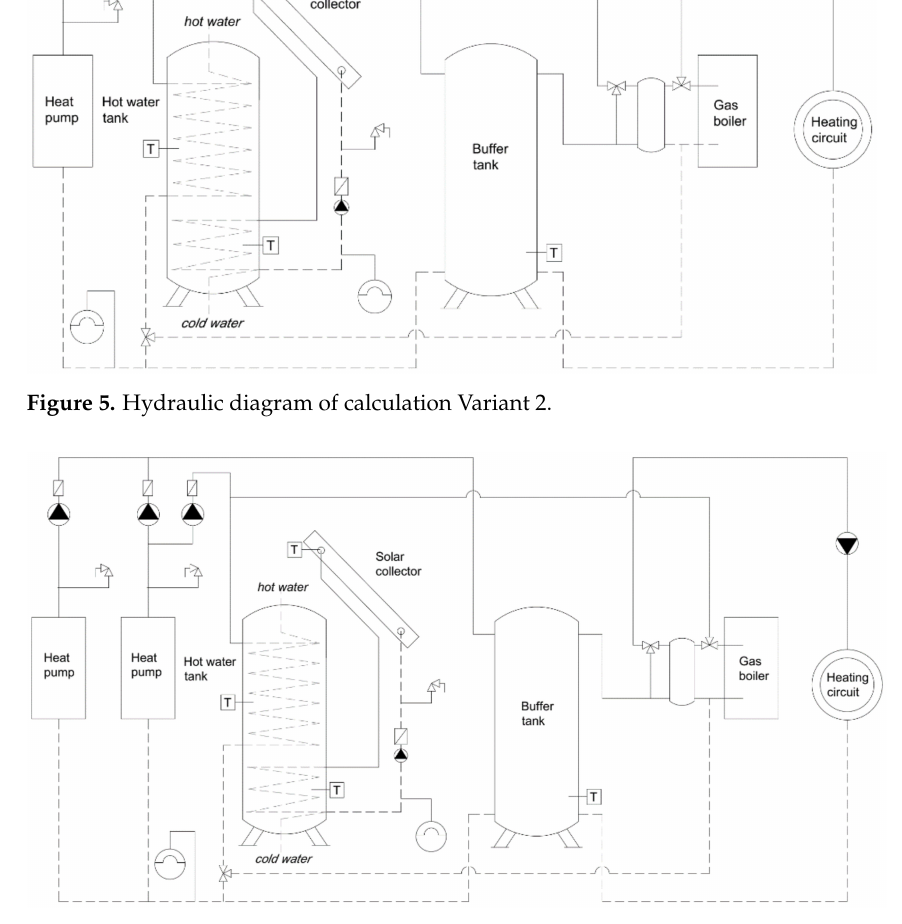
Figure 6. Hydraulic diagram of calculation Variant